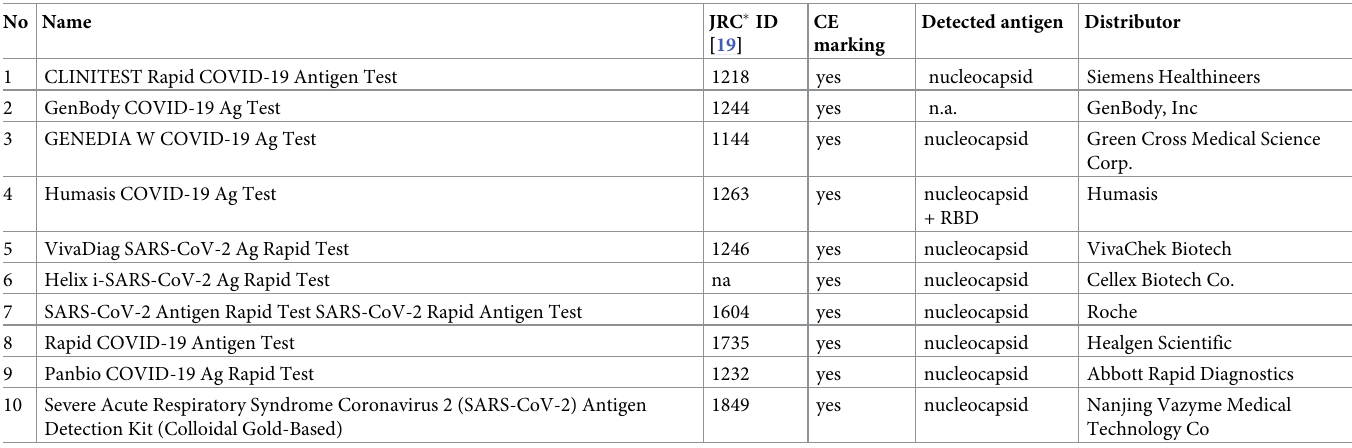
Table 1. List of tested SARS-CoV-2 Ag-RTDs and